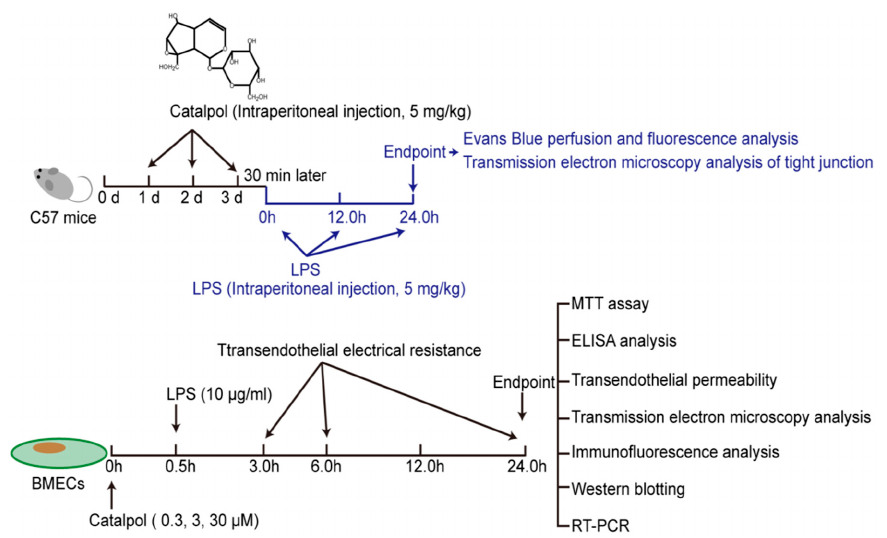
Figure 2. The study design of catalpol suppresses LPS-induced disruption of BMECs tight junction in vivo ( top ) and in vitro ( bottom ). BMECs, brain microvascular endothelial cells.